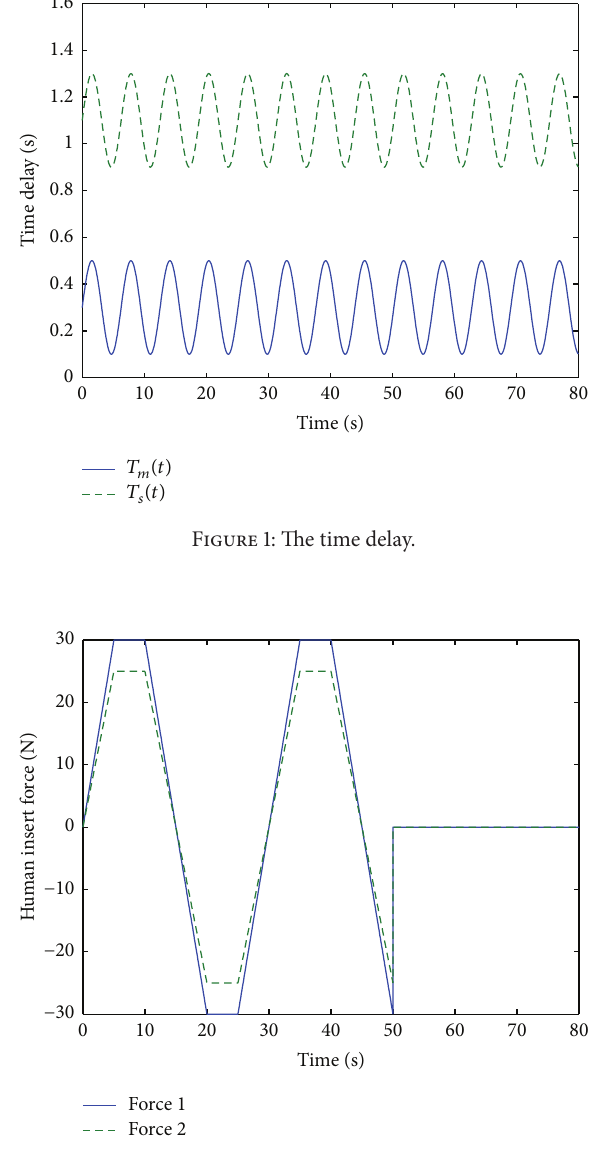
Figure 2: The human insert